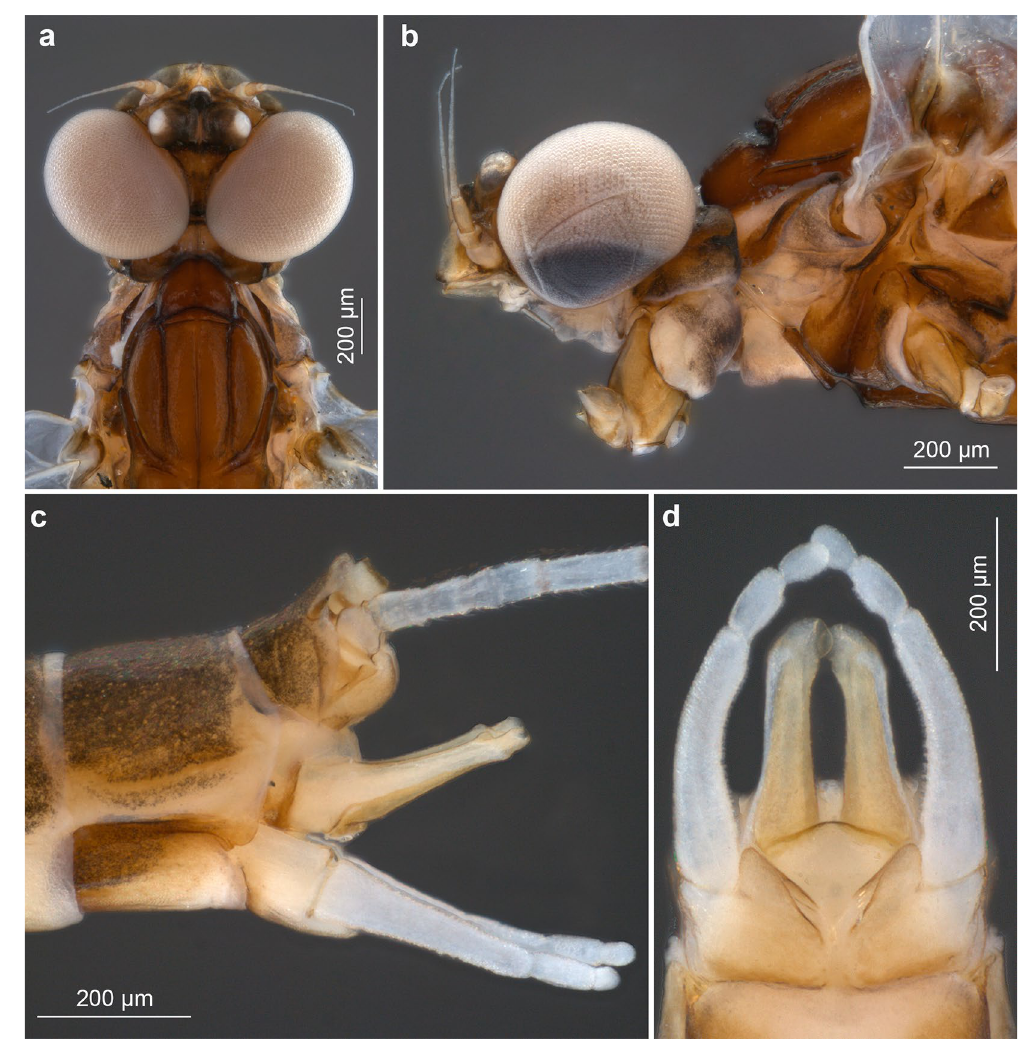
Figure 7. Calliarcys van Godunko & Bauernfeind, 2015 , male imago, paratype [Turkey; Soldán T. & Bojková J. coll.]: ( a ) head and anterior part of thorax in dorsal view; ( b ) head and anterior part of thorax in left lateral view; ( c ) tip of abdomen with genitalia in left lateral view; ( d ) genitalia in ventral view.